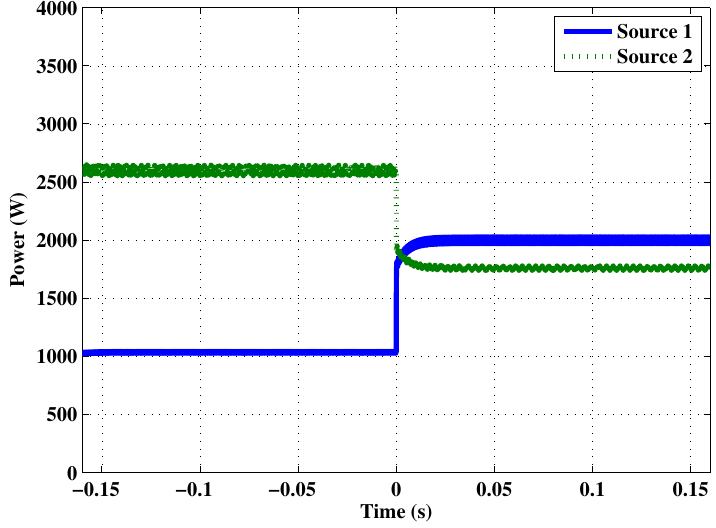
Figure 4. Simulation results for power supplied by Sources 1 and 2 during a step change in wind